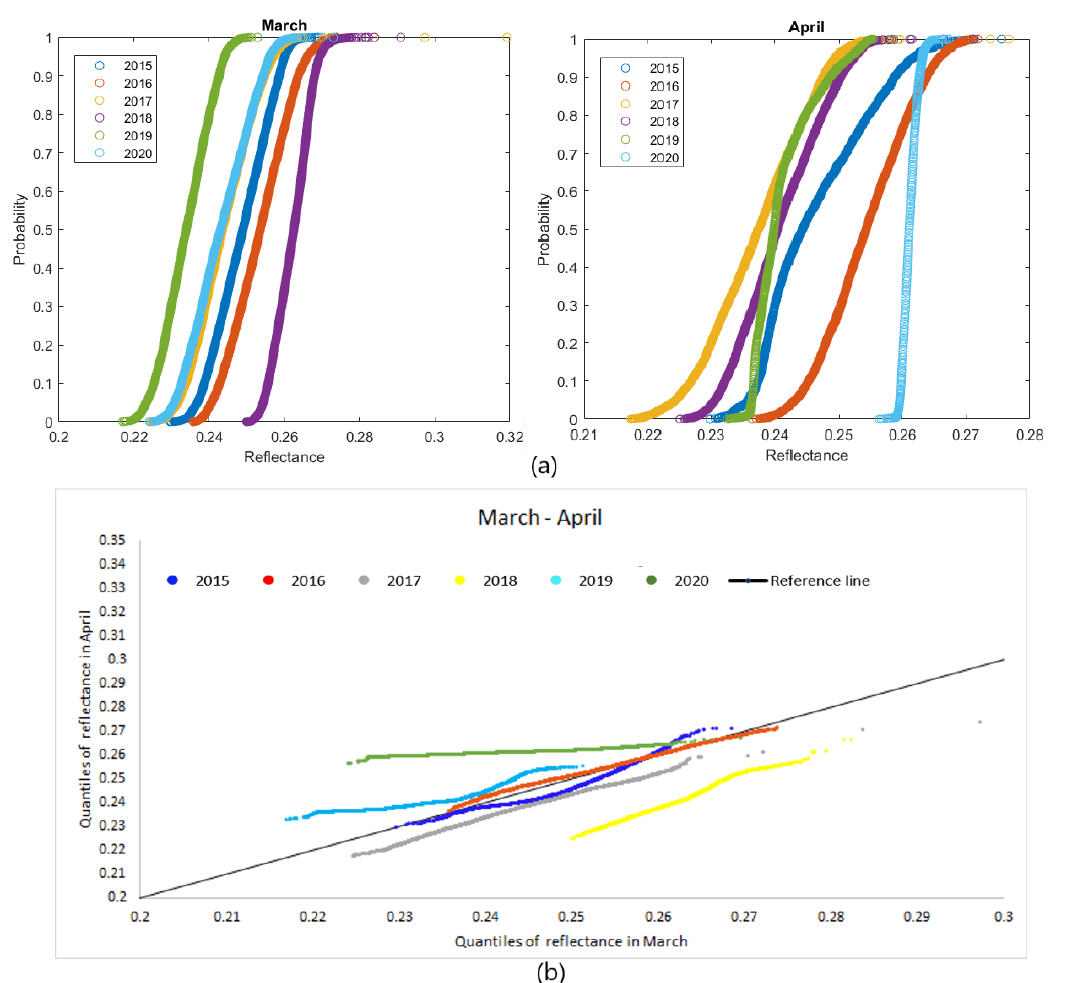
Figure 5. Comparison of B2 surface reflectance for months March and April in years 2015 to 2019. ( a ) ECDF for B2 SR; ( b ) Q–Q plot for B2